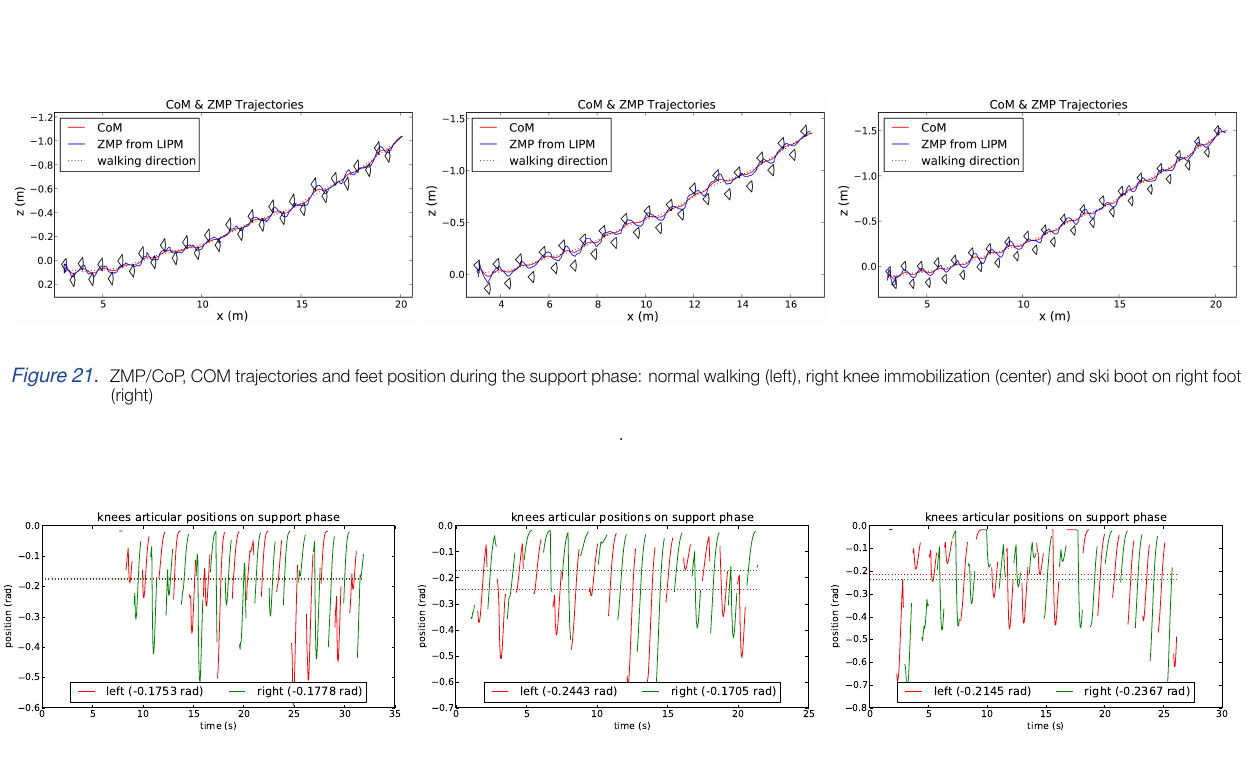
Figure 22. Knees angular positions: normal walking (left), right knee immobilization (center) and ski boot on right foot (right)